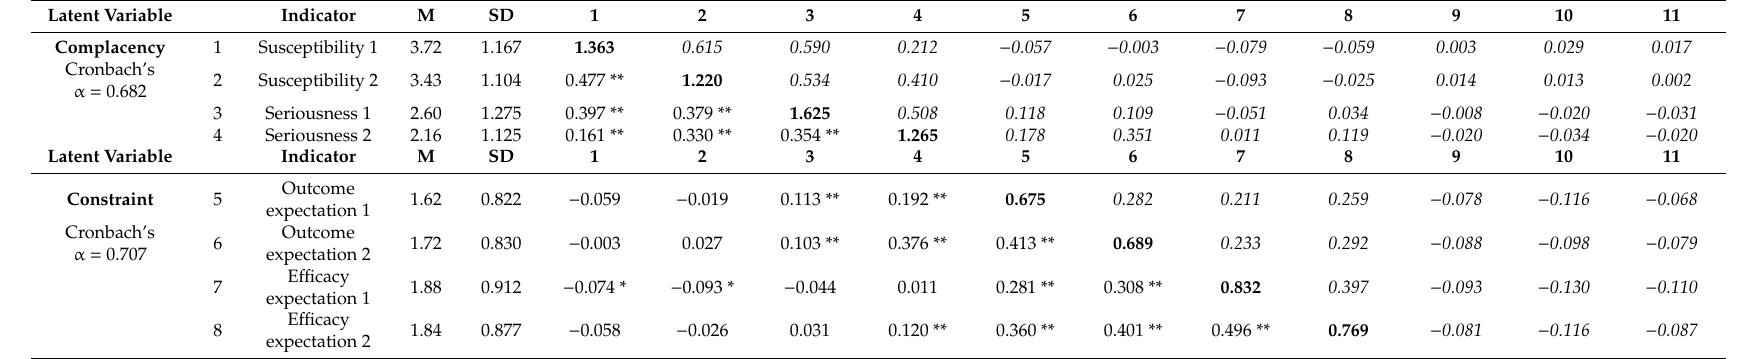
Table 3. variance, covariance, and correlations of indicators, Cronbach’s α for constructed latent variable